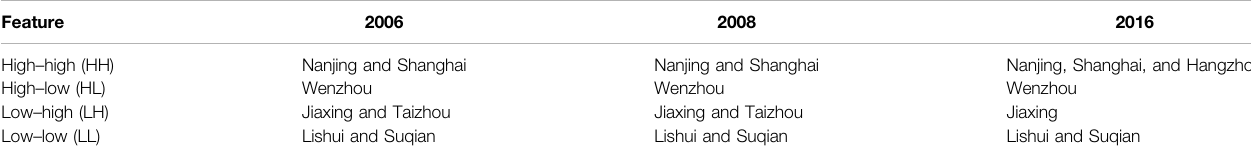
TABLE 6 | Results of the Lisa analysis on the linkage ef fi ciency of logistics industry and manufacturing industry in the Yangtze River Delta in 2006, 2008, and 2016.